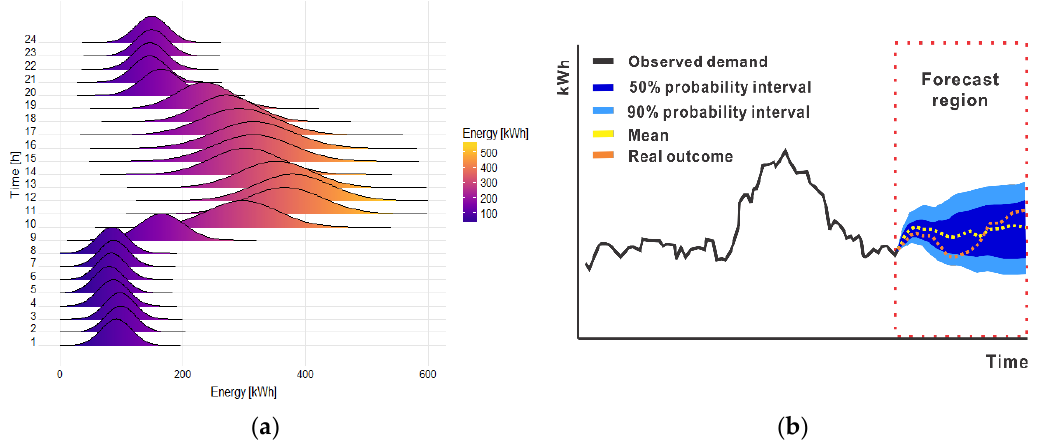
Figure 1. ( a ) DPD via density forecast; ( b ) Probabilistic forecast with confidence interval.